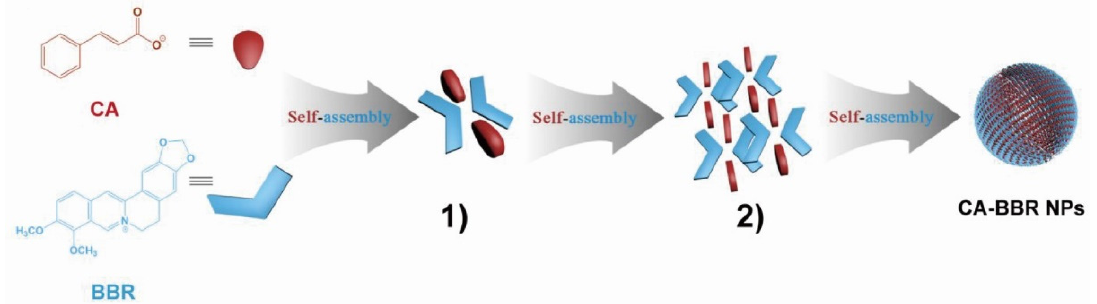
Figure 1. Schematic representation of the self-assembly mechanism of the cinnamic acid–berberine supramolecules (CA–BBR NPs). ( 1 ) One-dimensional self-assembled unit of CA–BBR supramolecules. ( 2 ) Three-dimensional packing structure of CA–BBR supramolecules [15] .